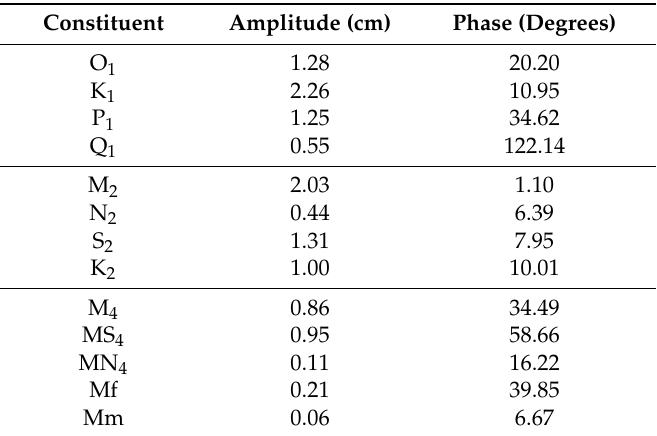
Table 2. Maximum absolute differences along the entire EC2015 boundary between the TPXO7.2 and FES2012 global tidal database